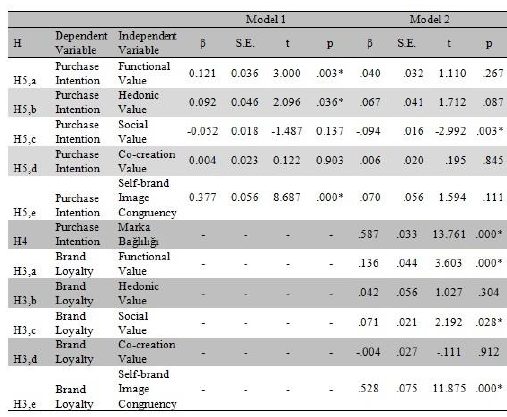
Table 4: Model 1 and Model 2